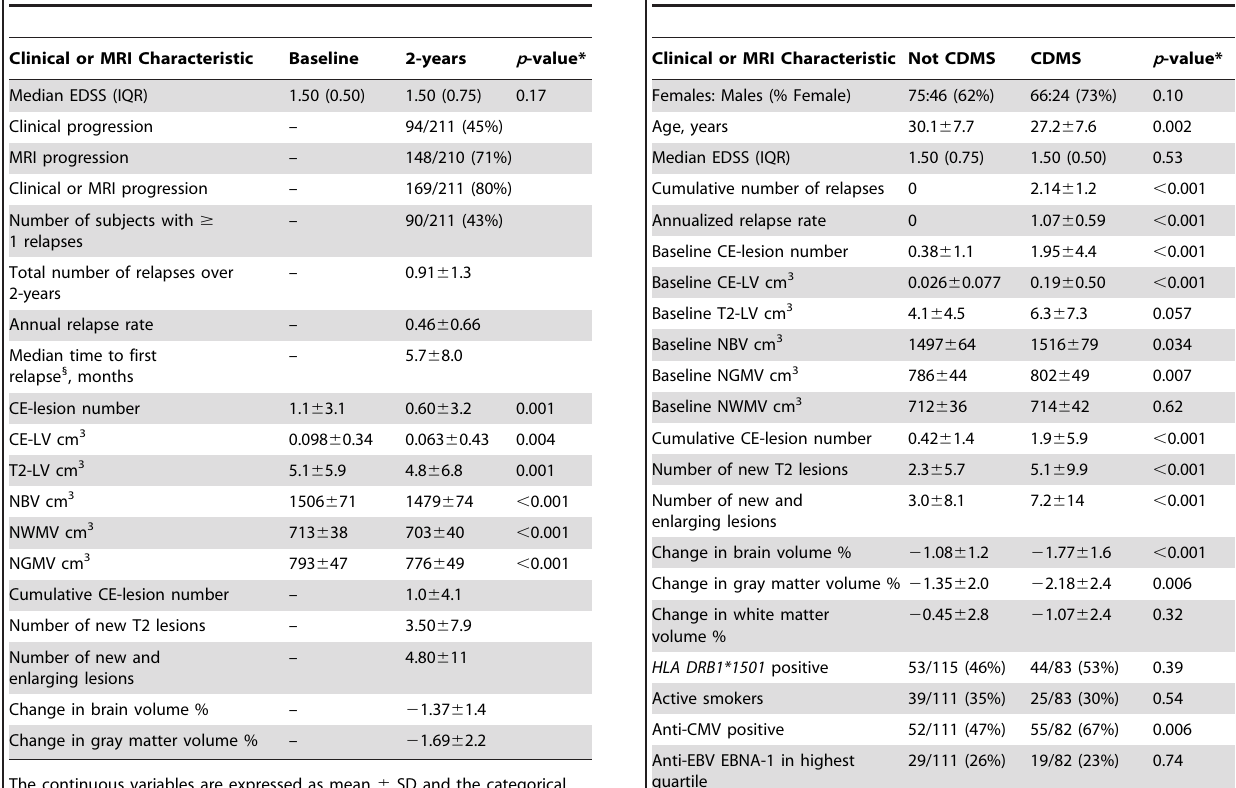
Table 3. Baseline clinical, MRI and other characteristics and changes of patients progressing to CDMS in 2-years.